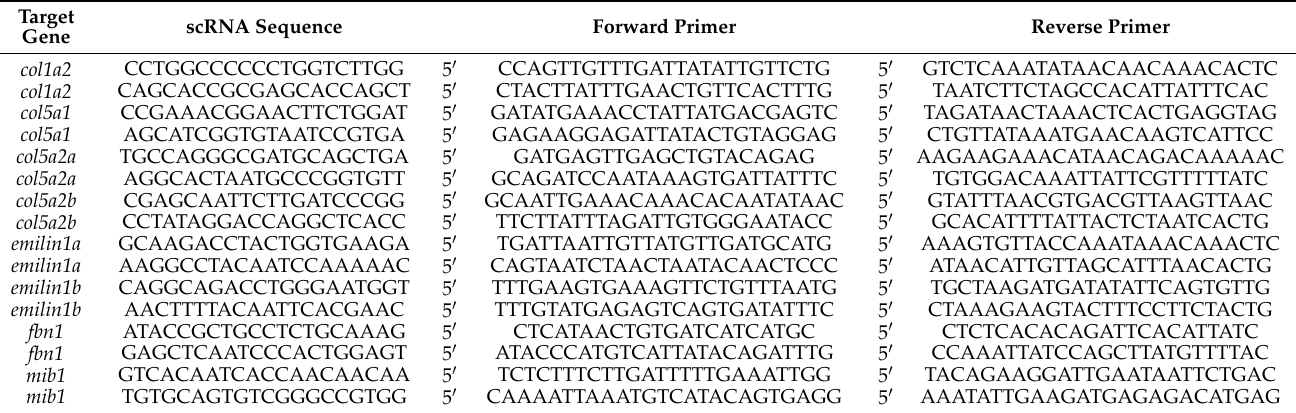
Table 1. scRNAs and primers used to perform T7 assays. For each gene, two target-specific scRNAs were designed. Flanking primers generating amplicons between 300–600 bp were also generated to assess whether indel mutations were being generated at the desired locations. Forward Primer Reverse